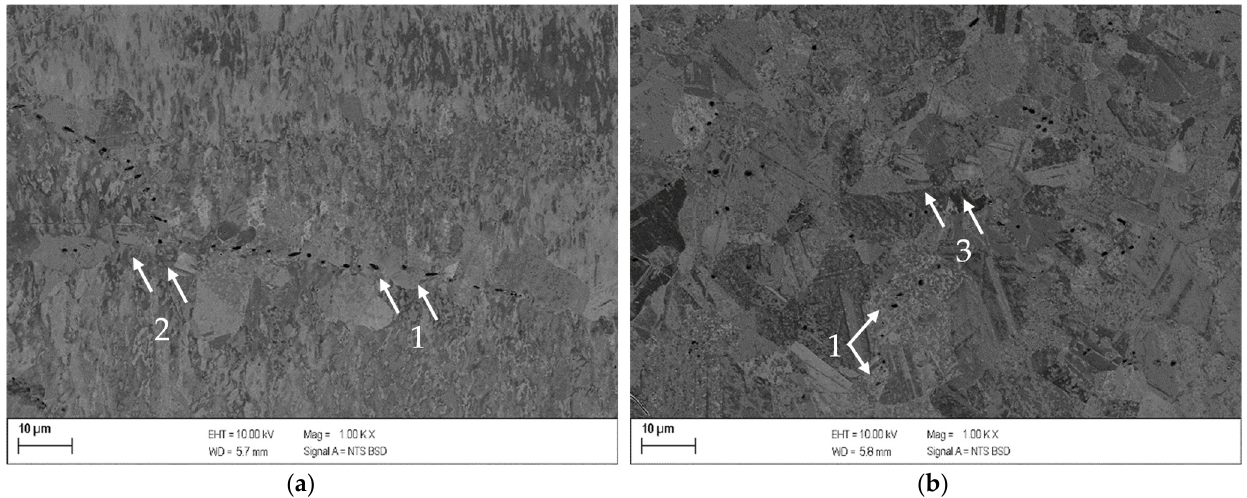
Figure 5. Microstructural evolution of CuCr0.7 during DSC measurements: specimen with 75% cross section reduction due to cold rolling; ( a ) condition 1; ( b ) condition 2; showing a fine network of undissolved chromium phases (1), recrystallization in small newly built grains (2), and secondary recrystallization in larger newly built grains (3).